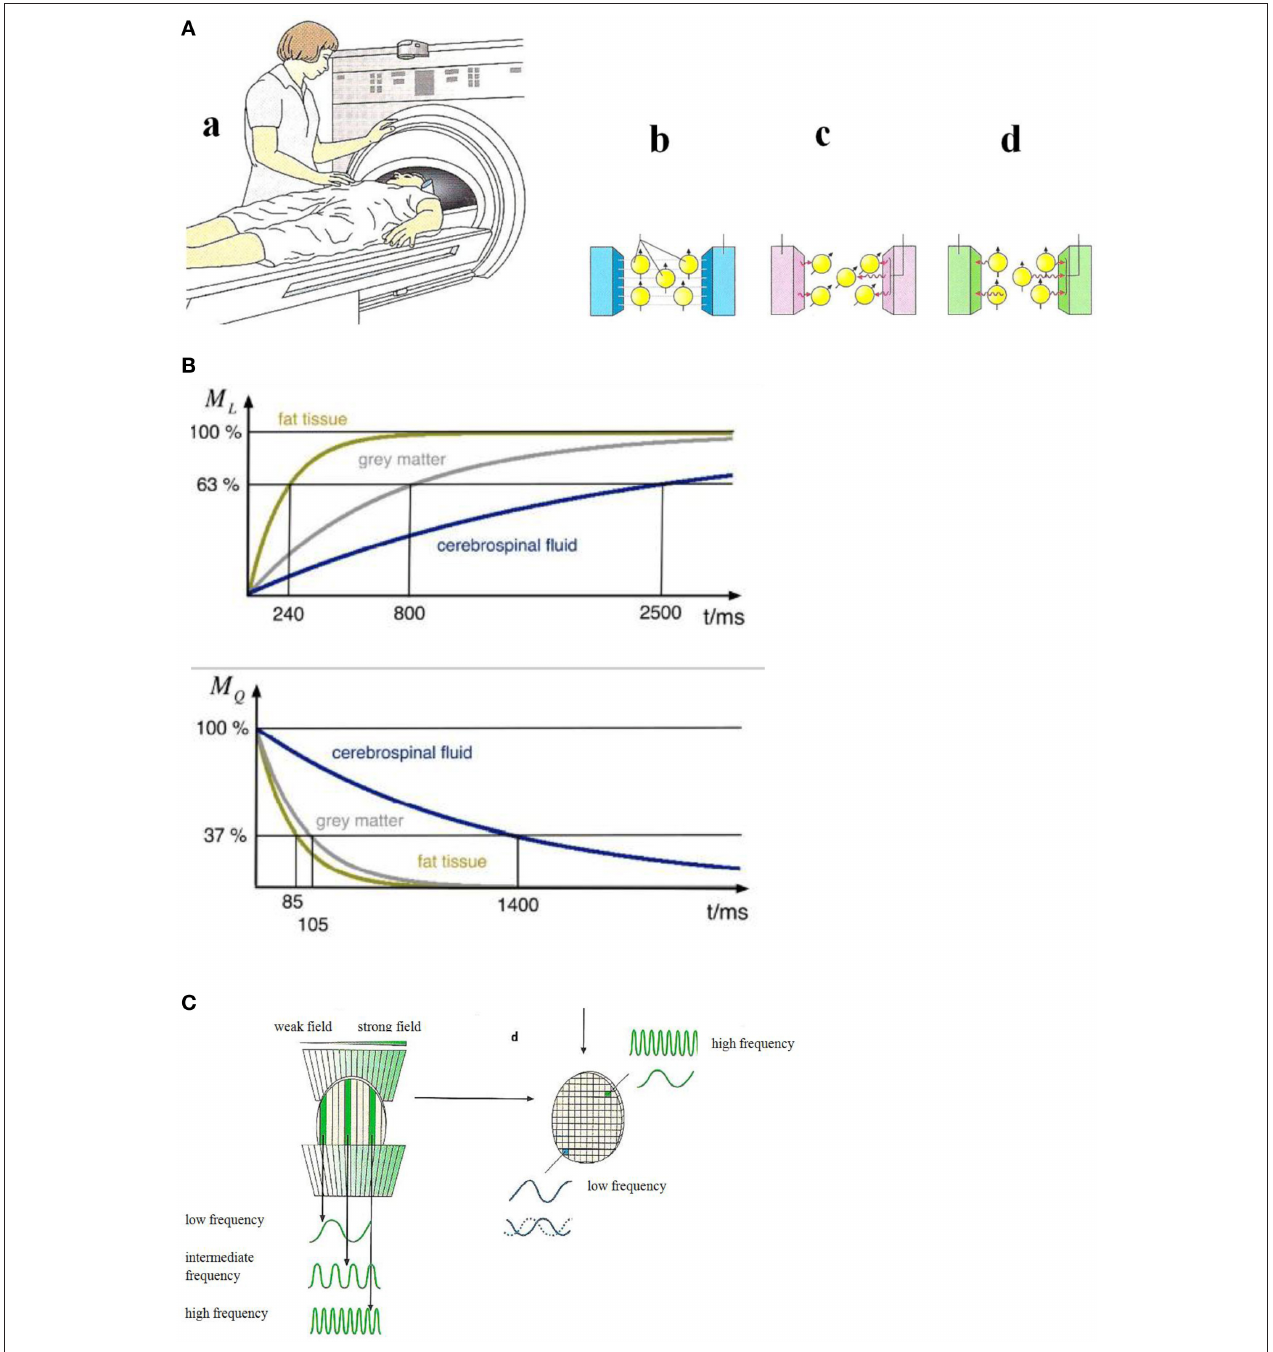
FIGURE 4 | (A) Principles of magnetic resonance tomography (Birbaumer and Schmidt, 2010). (a) The patient is moved into the center of the MRI scanner. (b) A strong homogeneous magnetic field aligns the magnetic moments of the protons in in the patient’s body. (c) An RF-pulse excites the proton magnetic moments to precession which gives rise to an alternating voltage signal in the detector. (d) After the switching-off the RF-pulse the proton magnetic moments relax to the initial orientation. The relaxation times (see B ) are measured. Reprinted with permission from Birbaumer and Schmidt (2010) © 2010 Springer. (B) Nuclear magnetic relaxation times T1 (top) and T2 (bottom) of hydrogen nuclei for various biological materials (Schnier and Mehlhorn, 2013). Reprinted with permission from Schnier and Mehlhorn (2013) © 2013 Phywe Systeme. (C) Spatial encoding of the local magnetic resonance information (Birbaumer and Schmidt, 2010). Due to a slicing (left) and finally a three-dimensional structuring (right) by means of gradient fields, the resonance frequency and the relaxation times can be assigned to a particular pixel. Reprinted with permission from Birbaumer and Schmidt (2010) © 2010 Springer.